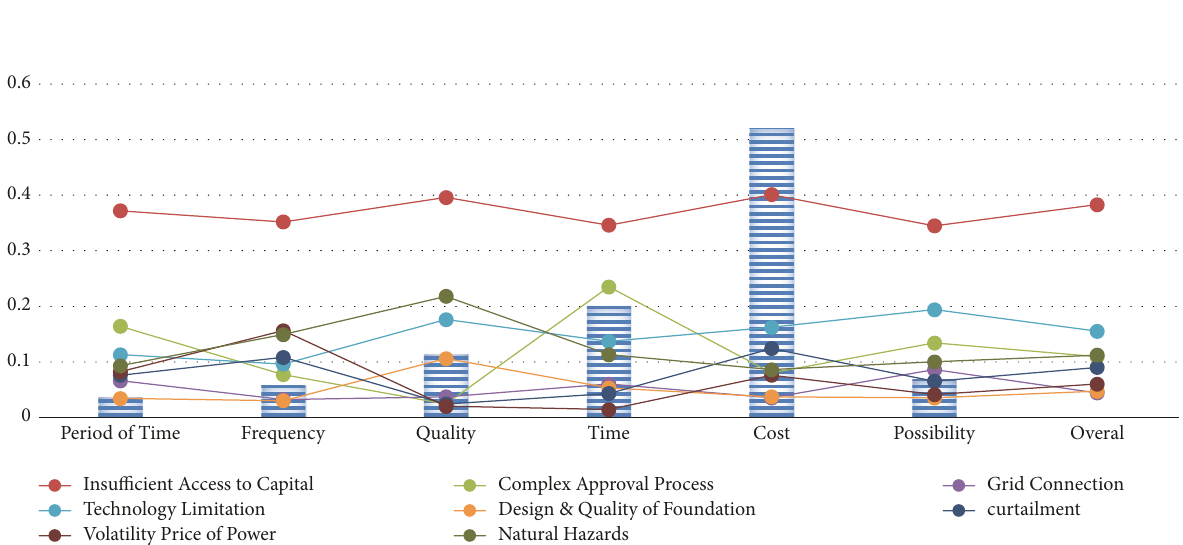
Figure 2: Performance sensitivity alternatives across risk